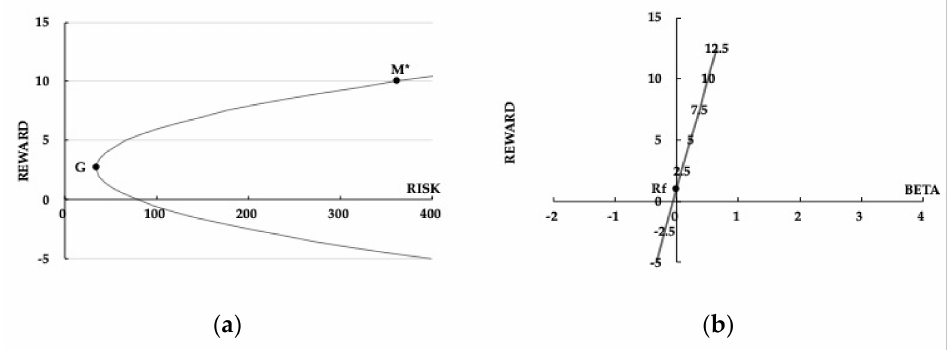
Figure 6. New betas and same portfolio rewards. ( a ) Smaller beta of the frontier trajectory; ( b ) steeper securities market